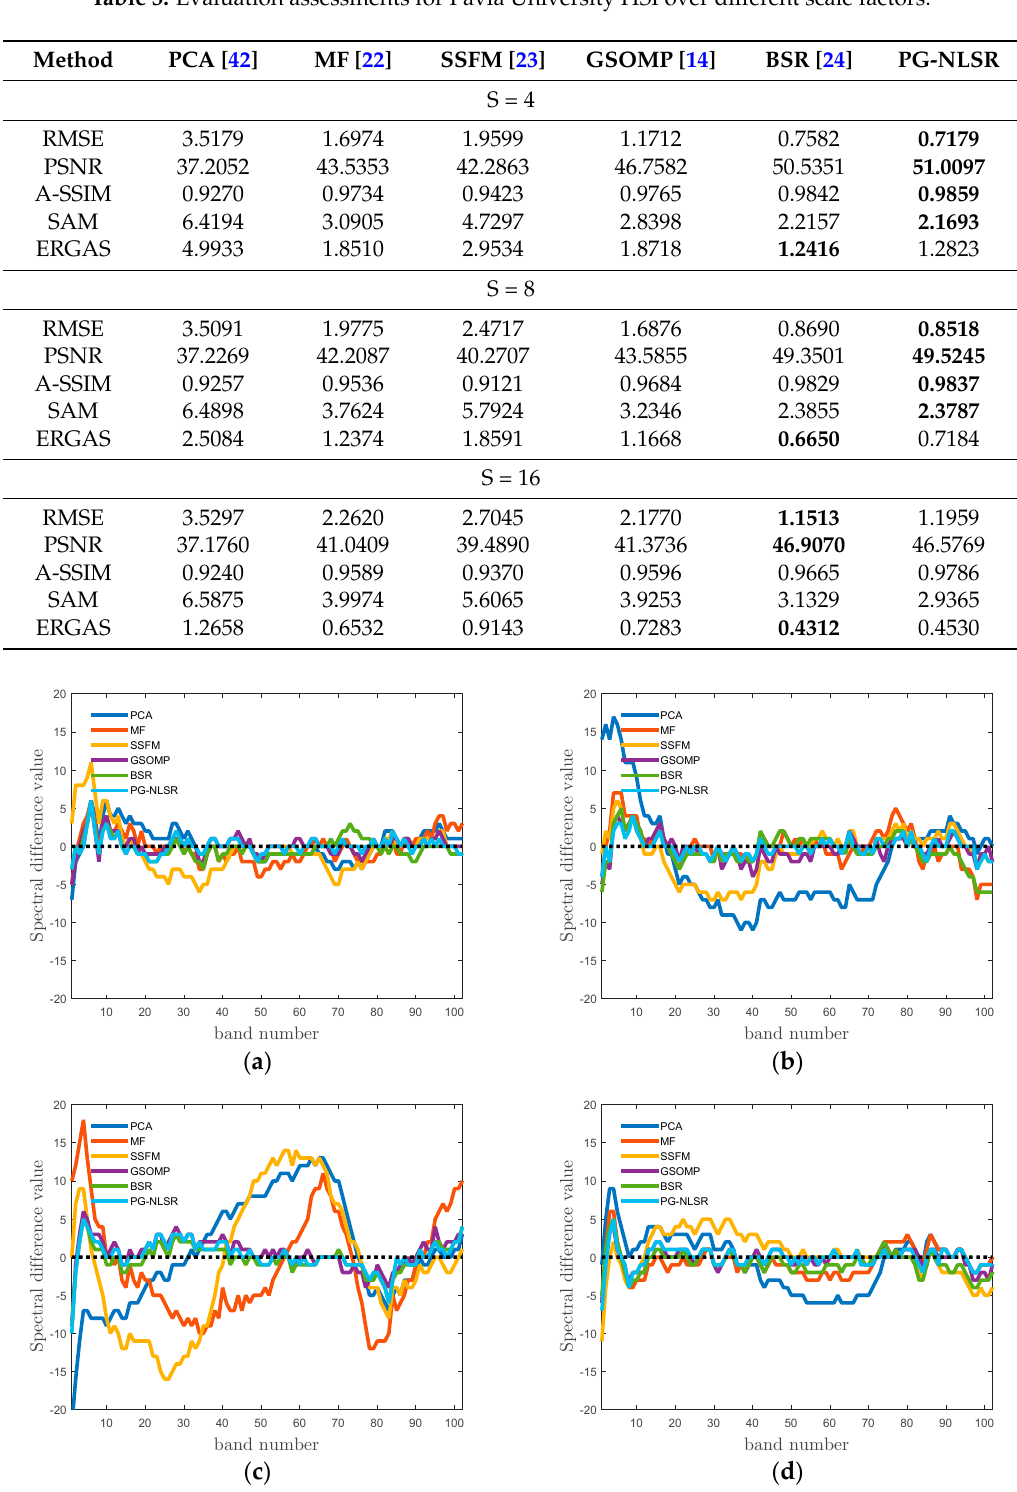
Figure 14. Spectral reflectance difference values on four single pixels of the Pavia University image: ( a ) (50, 50); ( b ) (100, 100); ( c ) (150, 150); and ( d ) (180, 200).